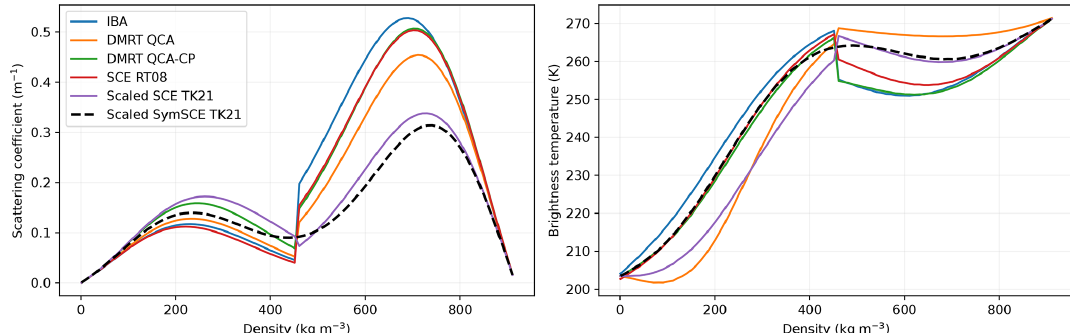
Figure 2. Scattering coefficient as a function of density for a variety of electromagnetic theories. The microstructure is made of sticky hard spheres with radius 0.4mm and stickiness 0.2. The frequency is